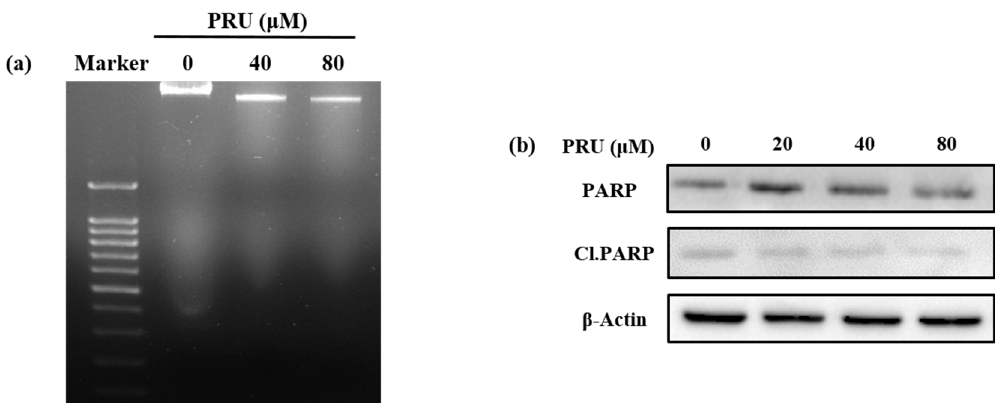
Figure 2. Analysis of apoptosis induction by prunetin. ( a ) Nuclear fragmentation assay on AGS cells treated with two concentrations of PRU (40 and 80 μ M), respectively. ( b ) Western blot analysis of important apoptotic marker proteins PARP and Cl.PARP on PRU (20, 40, and 80 μ M) treated AGS cells for 24 h.